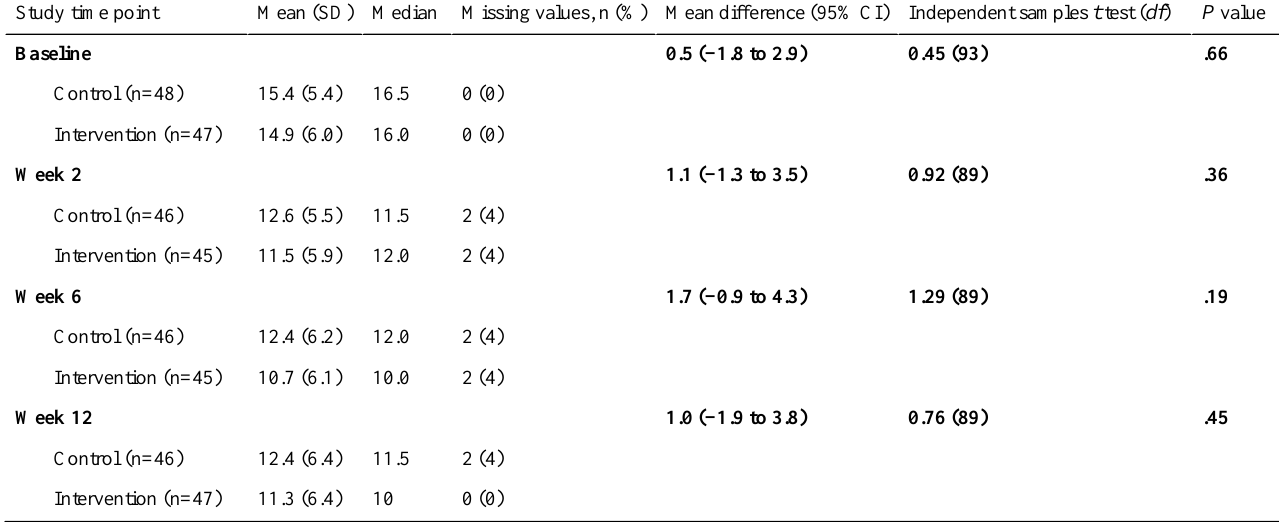
Table 6. Mean and median scores on the Patient-Health Questionnaire-9